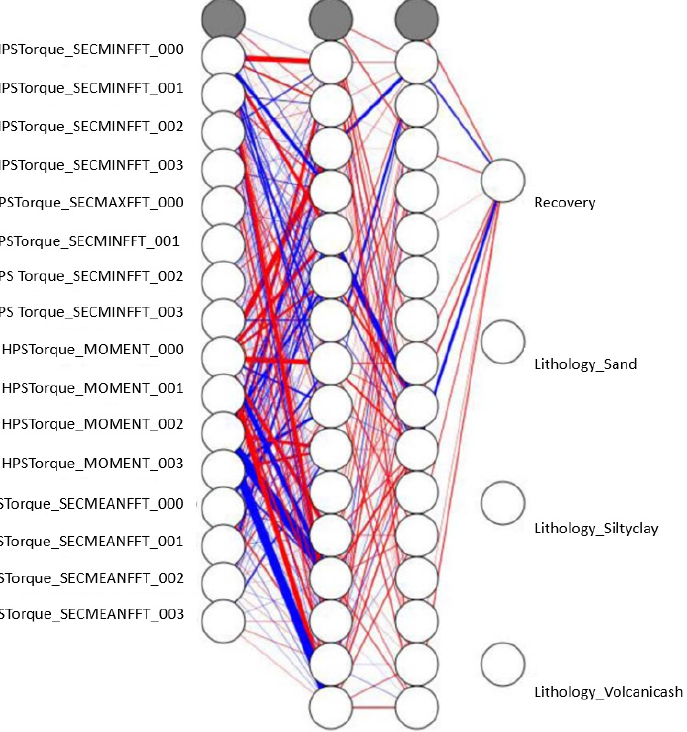
Figure 9. Neural network with 2 layers, 16 elements, and L1 regularization coefficient of 10. Reprinted with permission from [18], copyright Society of Petroleum Engineers (SPE), 2019.